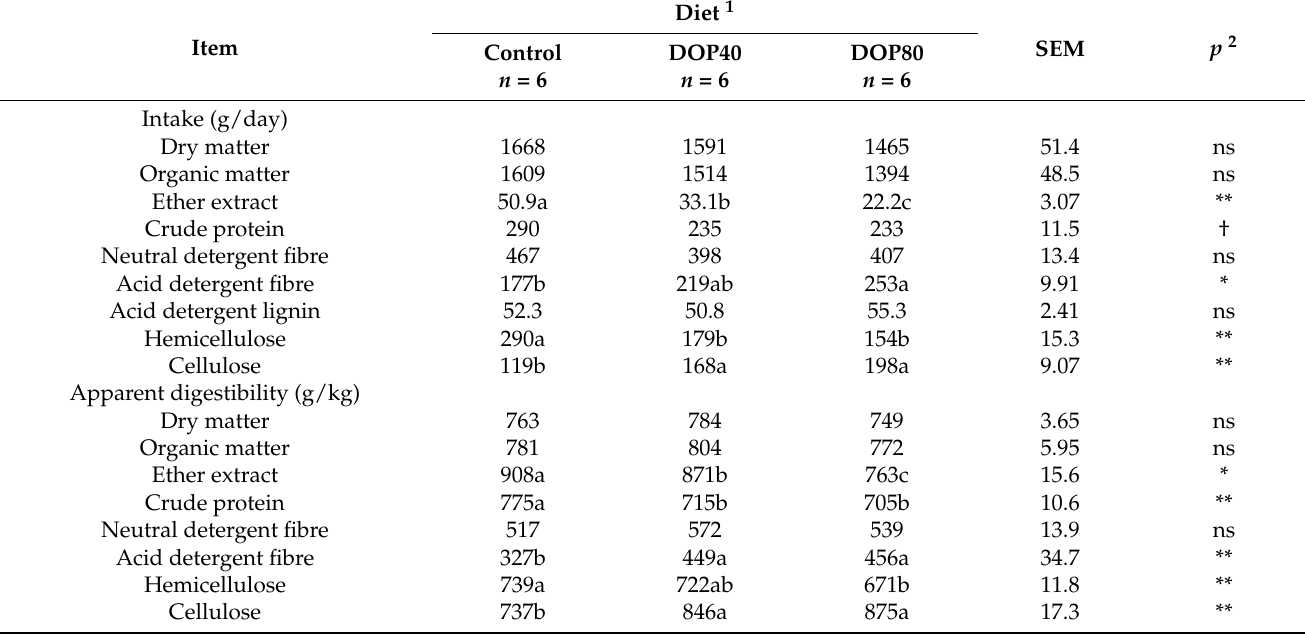
Table 3. Effects of experimental diets 1 on nutrients intake and apparent